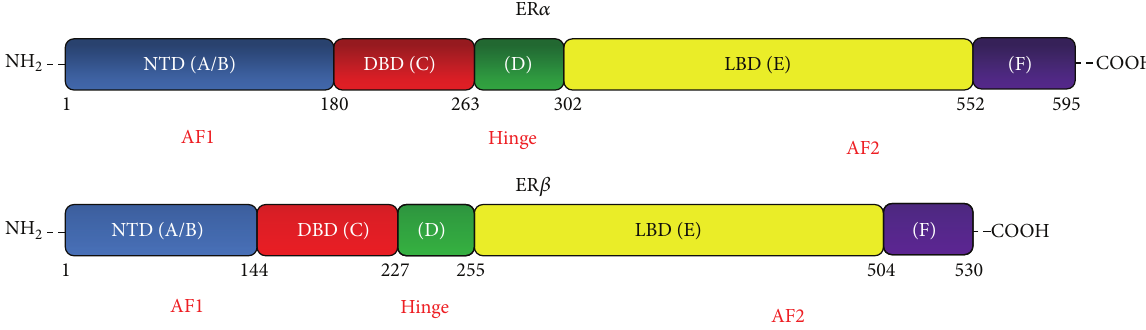
Figure 1: Domain structure of ER 𝛼 and ER 𝛽 . NTD: N-terminal domain, DBD: DNA-binding domain, and LBD: ligand-binding domain.